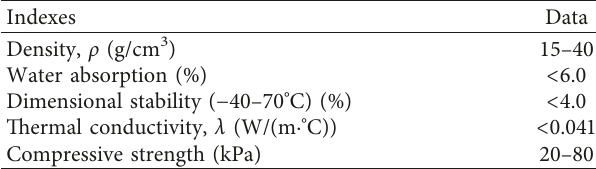
Table 5: Physical indexes for the EPS insulation board.